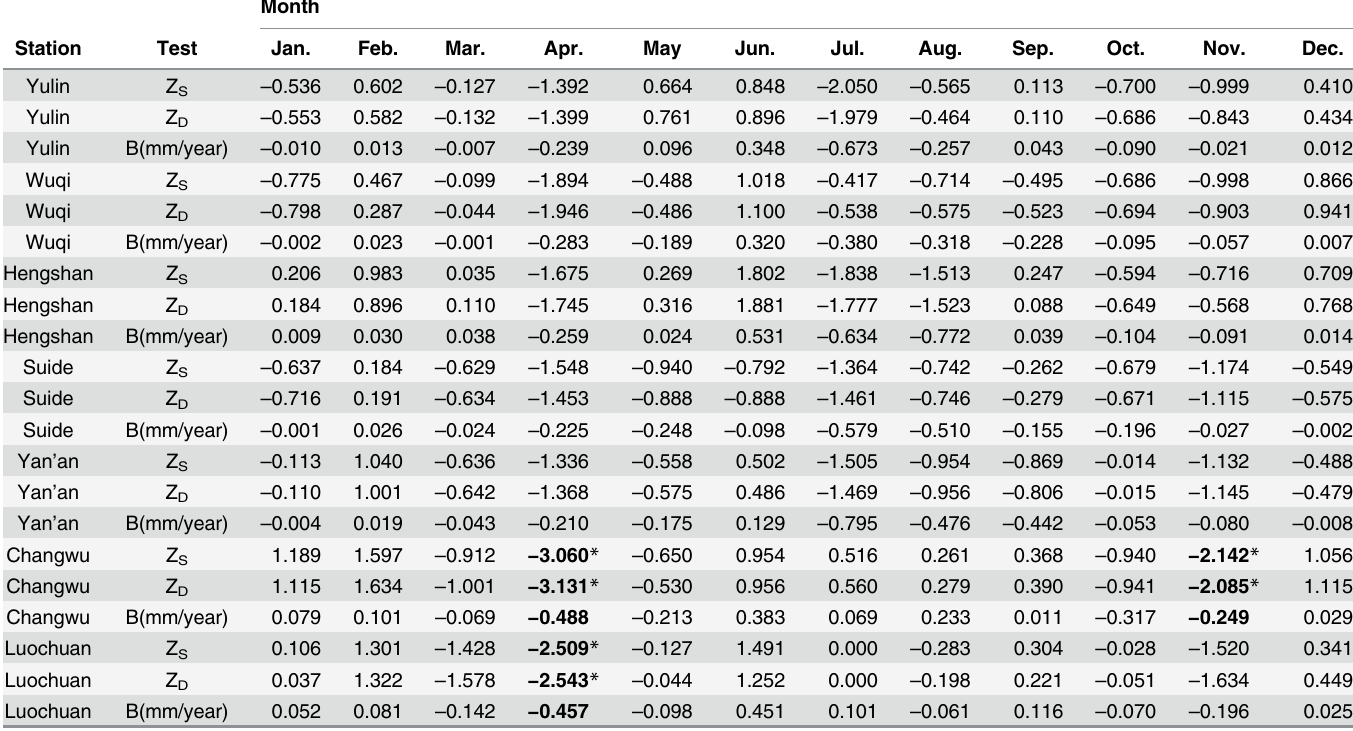
Table 6. Results of the statistical tests for monthly precipitation during 1957 –